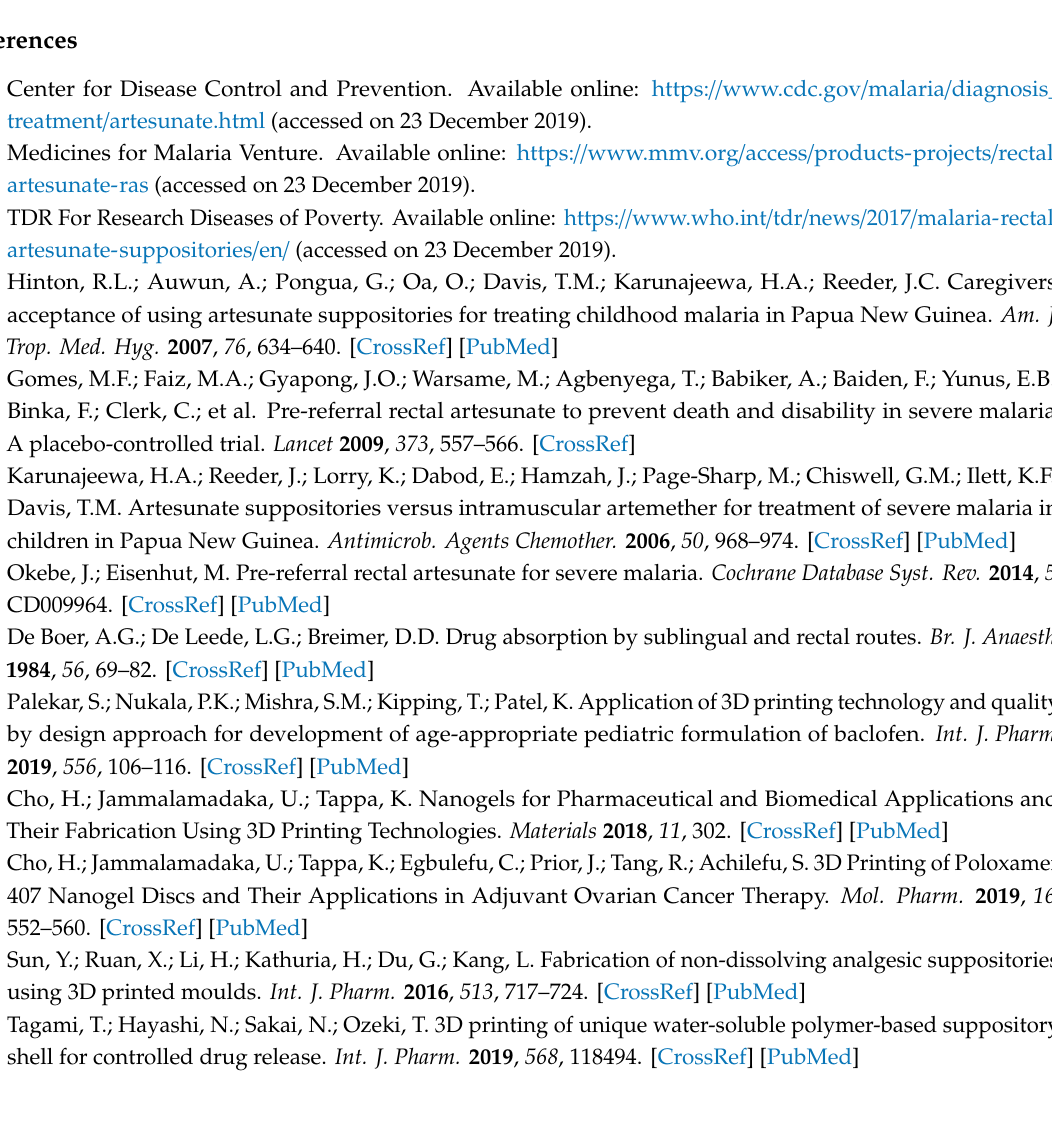
Figure S1: Release profiles of artesunate from suppositories each carrying 124 mg artesunate and those each carrying 63 mg of artesunate in PBS (pH 7, 37 ◦